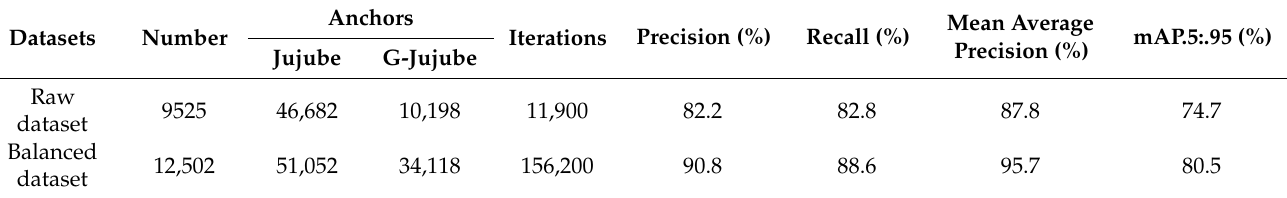
Table 3. Comparative results after data